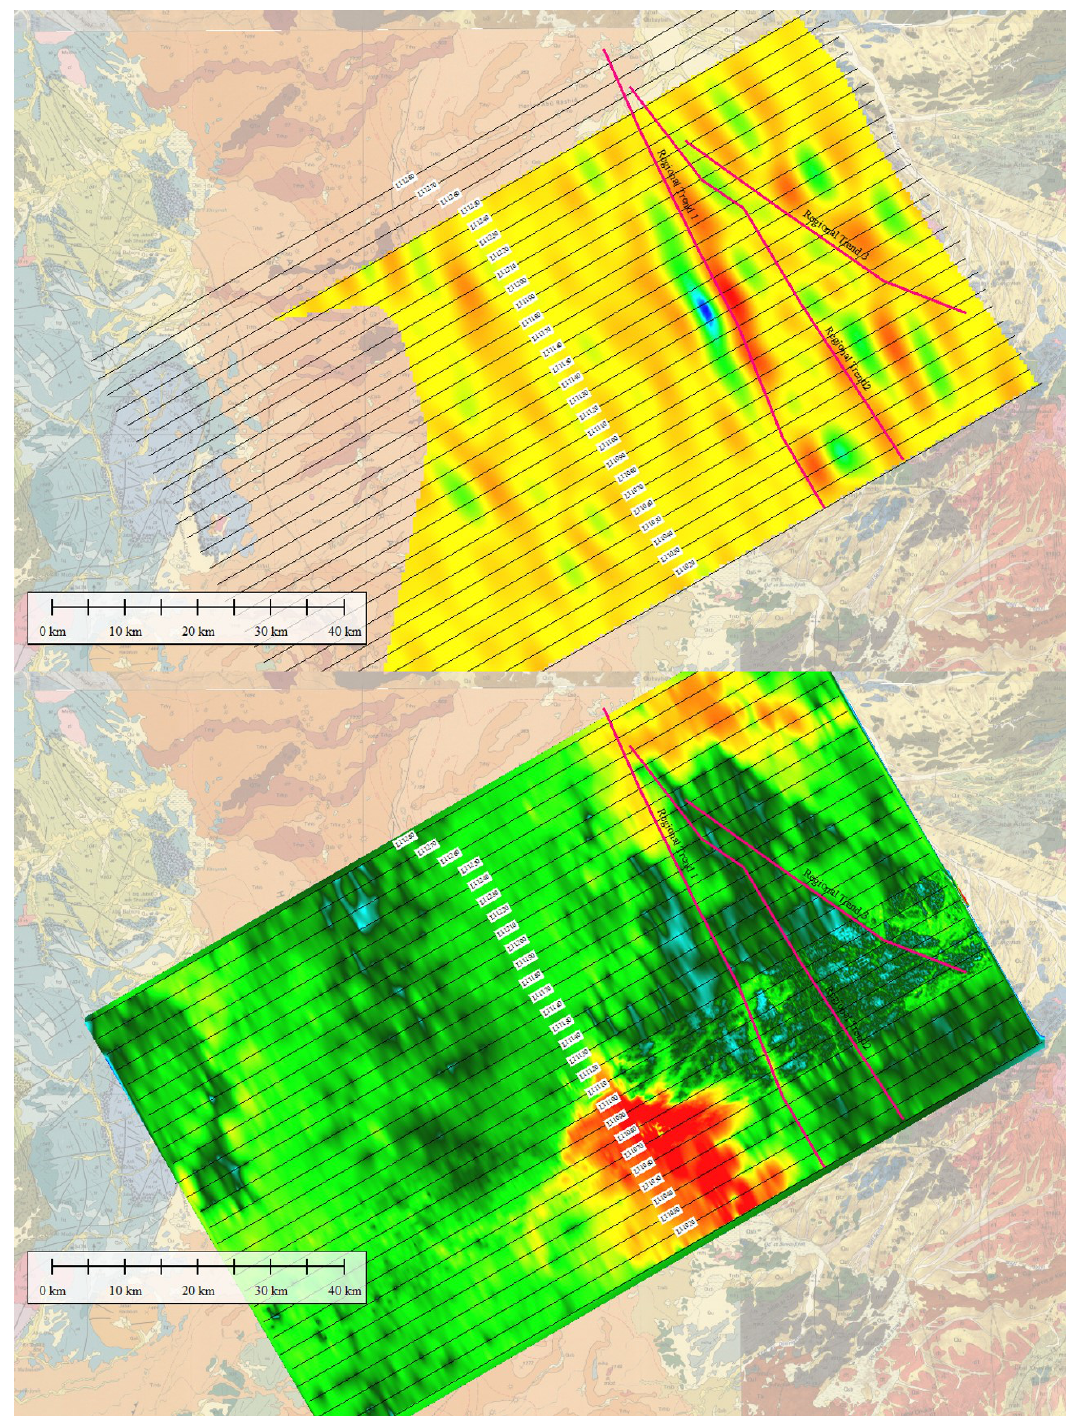
Figure 8. Maps of the density ( top panel) and conductivity ( bottom panel) distribution in the survey area at a depth of 100